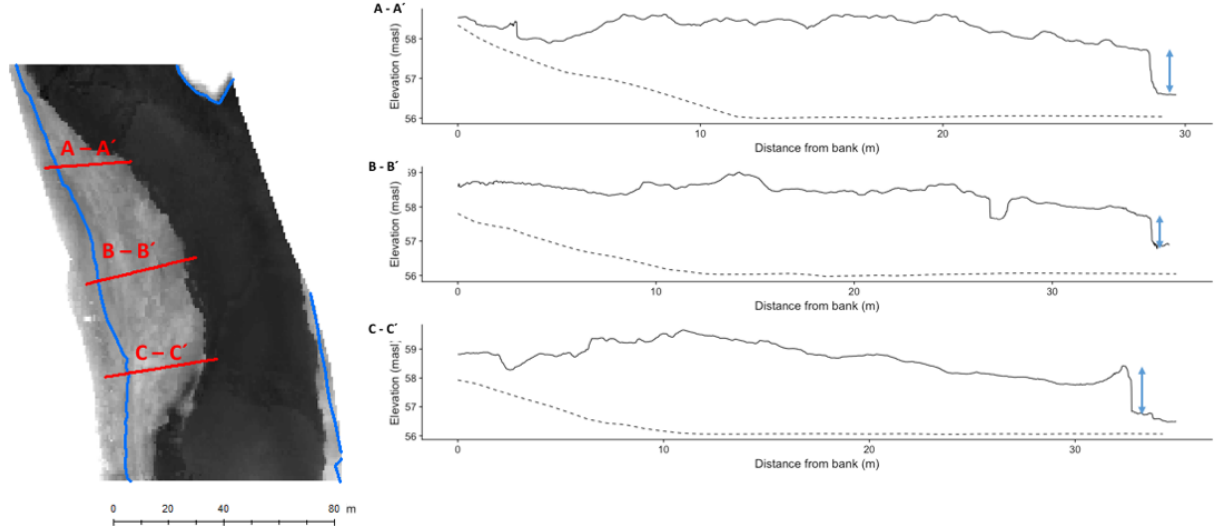
Figure 2. Cross sections through the Gaula ice jam at three different locations marked A–A (cid:48) , B–B (cid:48) and C–C (cid:48) . The height of the shear wall of the ice jam is marked with an arrow in each cross section. The dashed line indicates the ground level from the 1m resolution Norwegian DEM.